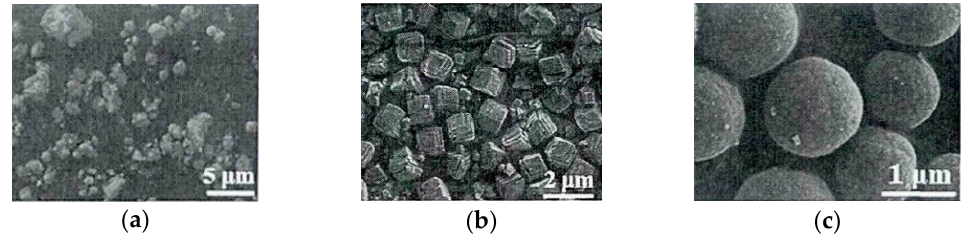
Figure 8. SEM images under different reaction conditions ( a ) Molar ratio of ethanol to EG = 1:1 and 180 °C for 4 h; ( b ) EG alone and 180 °C for 10 h; ( c ) Molar ratio of ethanol to EG = 1:1 and 180 °C for 180 ◦ C for 4 h; ( b ) EG alone and 180 ◦ C for 10 h; ( c ) Molar ratio of ethanol to EG = 1:1 and 180 ◦ C for 10 h. [38]. 10 h.